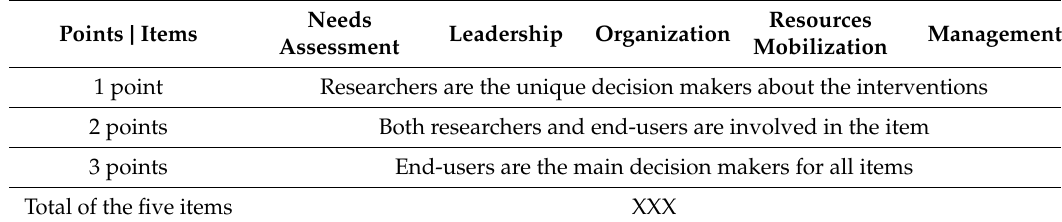
Table 1. Basis of the involvement